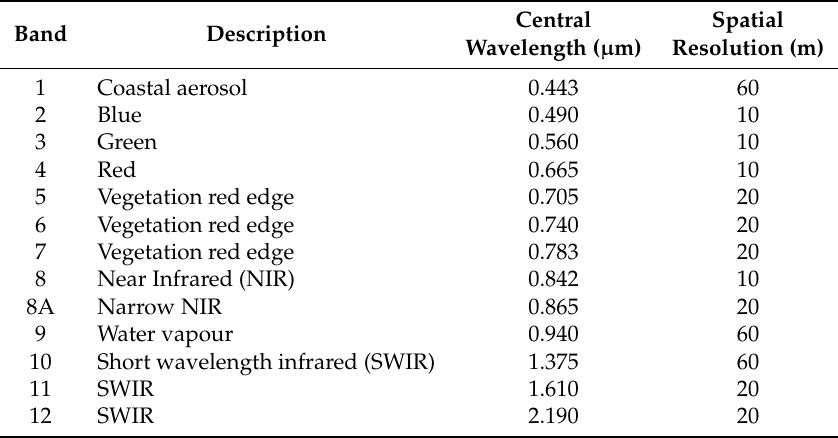
Table 1. Sentinel-2 spectral bands